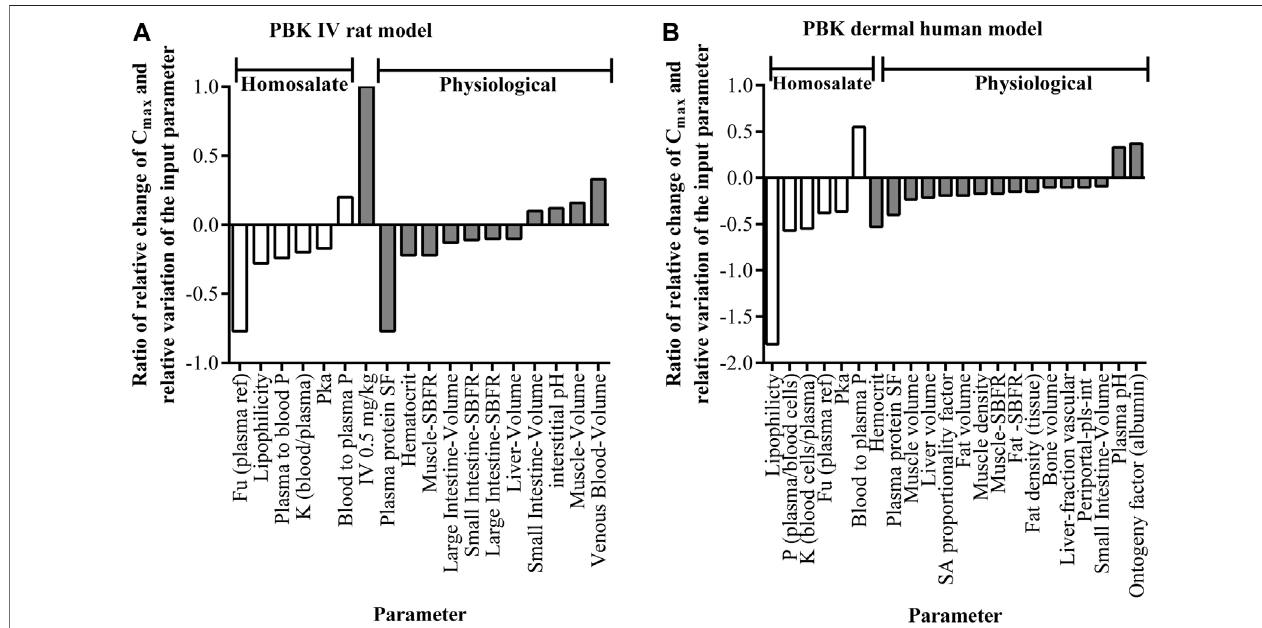
FIGURE 2 | The output of the sensitivity analyses of C max values for the (A) rat-IV PBK model (Dose: 0.5 mg/ kg, single) and (B) human dermal PBK model (dose 103 μ g/ cm 2 ,single).They-axisrepresents theratiooftherelativechangeofC max andtherelativevariationoftheinputparameterdenotedinthex-axis.Parameterswith sensitivitieslessthan absolute0.1arenotlisted.Blood toplasmaP (cid:1) blood toplasmapermeability; Fu (cid:1) fraction unbound;K (cid:1) partitioncoef fi cient;Periportal-pls-intP (cid:1) Periportal-plasma-interstitial permeability; plasma to blood P (cid:1) plasma to blood permeability; SBFR (cid:1) speci fi c blood fl ow rate; SF (cid:1) scale factor.